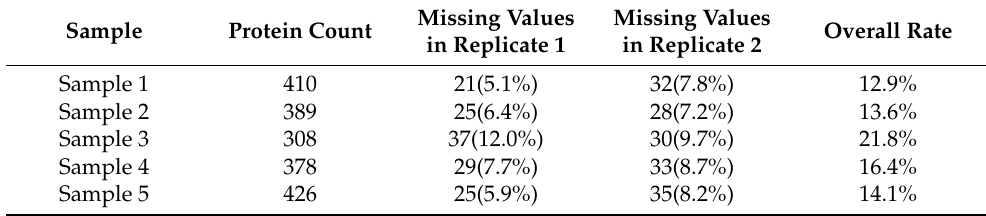
Table 6. Missing values between technical replicates of the same cervico-vaginal fluid samples.